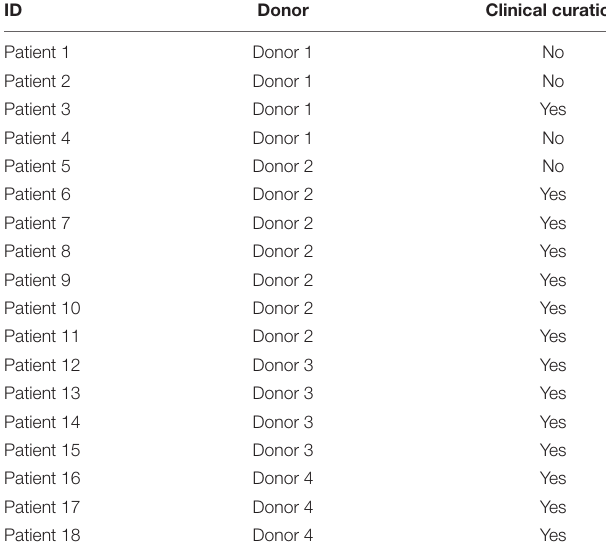
TABLE 3 | Donor-recipient pairs and clinical